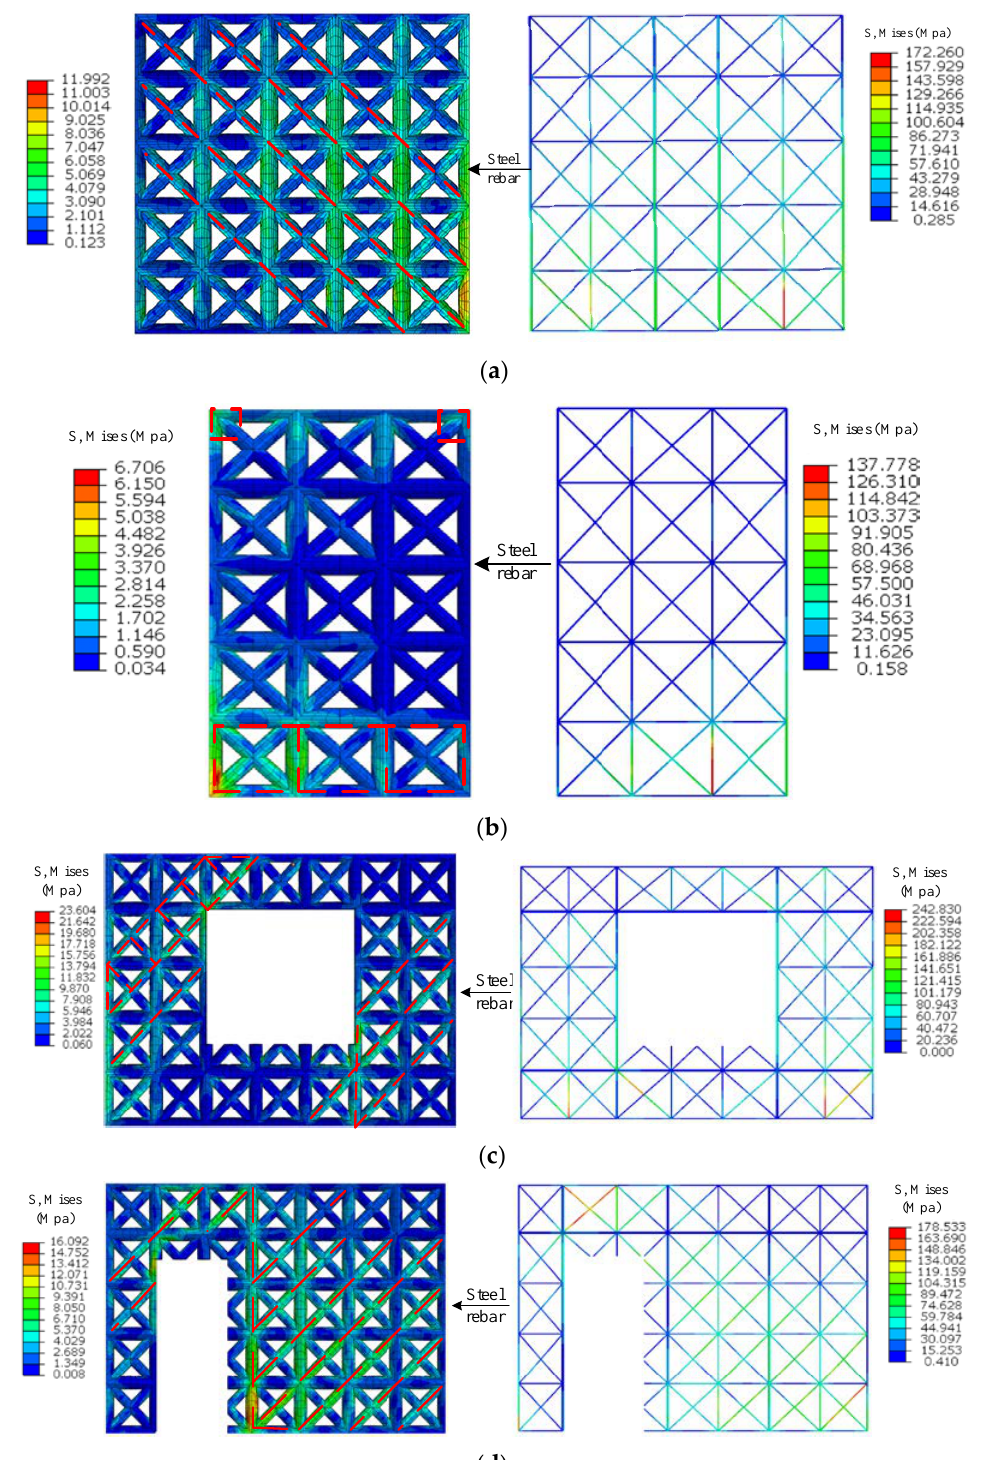
( a ) ( b ) Figure 13. Hysteresis curve of the star-type grid concrete wall structure. ( a ) Lander ground motions, ( b ) Wolong ground motions. 4.4. Failure Pattern of the Star-Type Grid Concrete Wall Considering the first story suffers maximum inter-story drift angle, Figure 14 shows the stress contours of star-type grid concrete walls in the first story under the Lander ground motion. For wall A, with an aspect ratio of 1:1, the stress is concentrated on the diagonal bracing and concrete lattice column, particularly along the diagonal structure line from the wall corner to the opposite one, conforming to the shear failure. In contrast, the stress is more minor in the concrete lattice beam. For wall B, with an aspect ratio of 5:3, the stress is primarily presented at the bottom and top of the wall, especially at the corners of the wall, while the stress is minimal in the middle of the wall, conforming to is smaller.